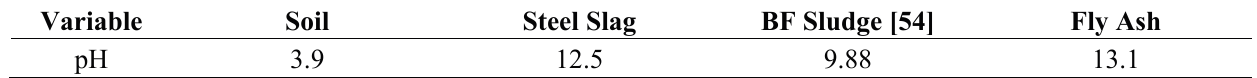
Table 9. Variation of pH in different sample matrices